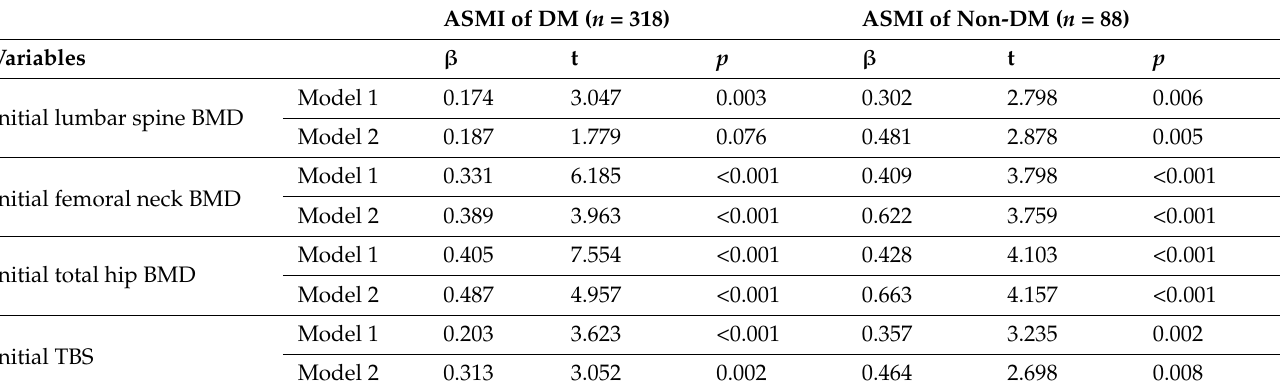
Table 3. Multiple regression analysis of bone-related parameters on ASMI. ASMI of DM ( n = 318) ASMI of Non-DM ( n =